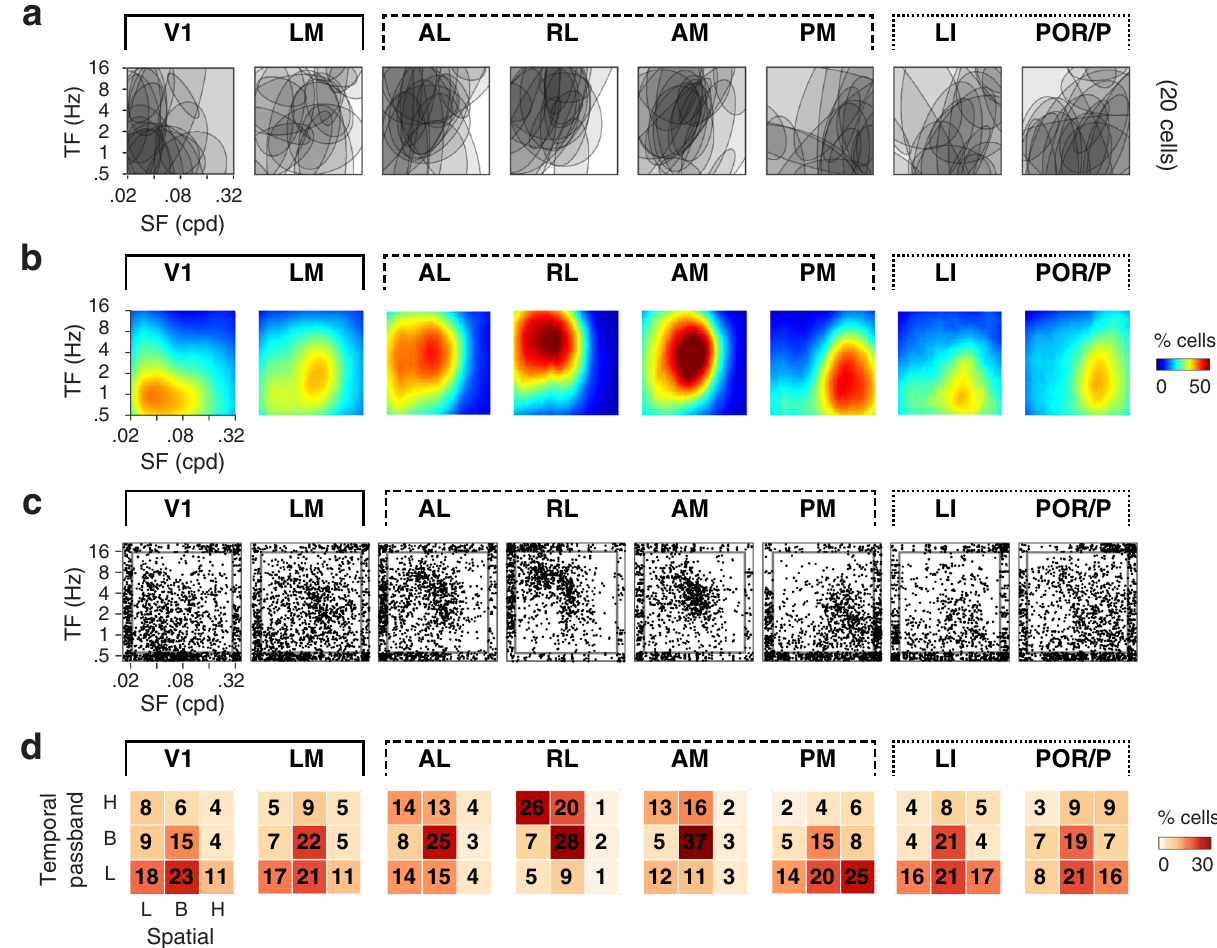
Fig. 2 Comparison of spatiotemporal frequency representations in V1, LM, and dorsal and ventral visual areas. For each characterized visual area: a Example spatiotemporal tuning. Overlaid halfmaximum regions of 2-dimensional spatiotemporal tuning for 20 randomly-selected cells. b Fraction of activated neurons as a function of center spatial and temporal frequency computed by averaging normalized half-maximum regions of tuning fi ts. Note how distinct visual areas respond to distinct ranges of spatiotemporal frequencies. c Scatter plots showing the distributions of peak spatiotemporal frequencies. Data points scattered at graph edges correspond to data points at the outer limits of spatial and temporal frequencies tested. d Fraction of neurons for